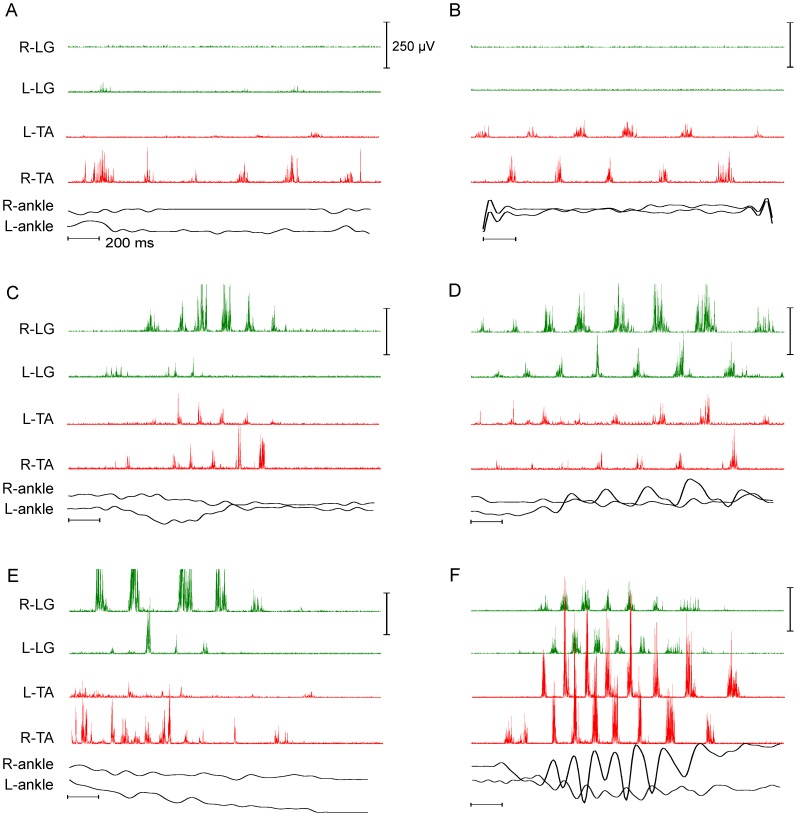
Variations in RLM EMG patterns at E19.Samples of RLMs from a single 24L experiment illustrate the combinations of muscle activity in EMG recordings commonly observed. A: The 6-burst sequence in R-TA RLM was unaccompanied by EMG activity in other muscles. B: The 6-burst RLM in R-TA was accompanied by a 6-burst sequence in L-TA. C: RLM sequences were generated concurrently in 3 muscles: R-LG, L-TA and R-TA. D: An 8-burst RLM in R-LG was accompanied by a 7-burst RLM in L-LG, and 4-burst RLMs in both L-TA and R-TA. Onset of L-LG bursts alternated with onset of R-LG bursts. E: The R-LG RLM was accompanied by extensive non-RLM activity in R-TA. F: Well-formed RLMs were expressed concurrently in all 4 EMG traces, and alternating left-right burst onsets were distinct in LG RLMs and TA RLMs. Also, L-LG and L-TA burst onsets alternated. RLM burst frequency also varied across RLMs within experiments, e.g., burst frequencies in D were slower than frequencies in F. Scales A–F: Vertical scale bars equal 250 µV (EMG) and 0.06 mm (ankle displacement). Horizontal scale bars equal 200 ms.